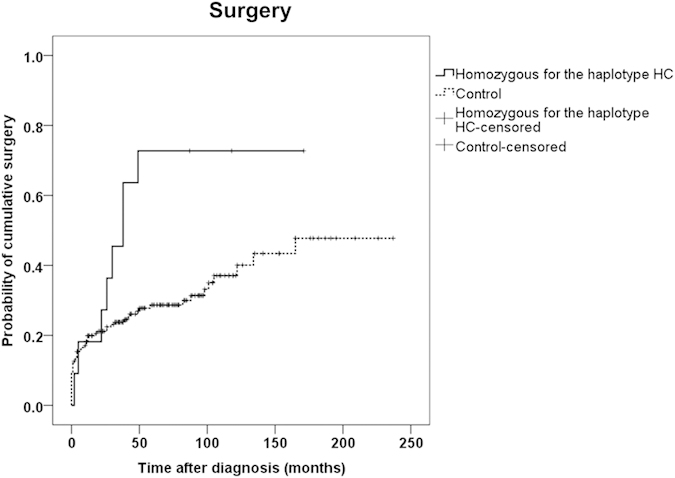
Probability of cumulative surgery curve in Korean CD patients during follow-up.The univariate Kaplan-Meier log-rank test was performed between homozygous for OCTN2 haplotype HC (solid line) and control (dashed line). log-rank P = 0.015.